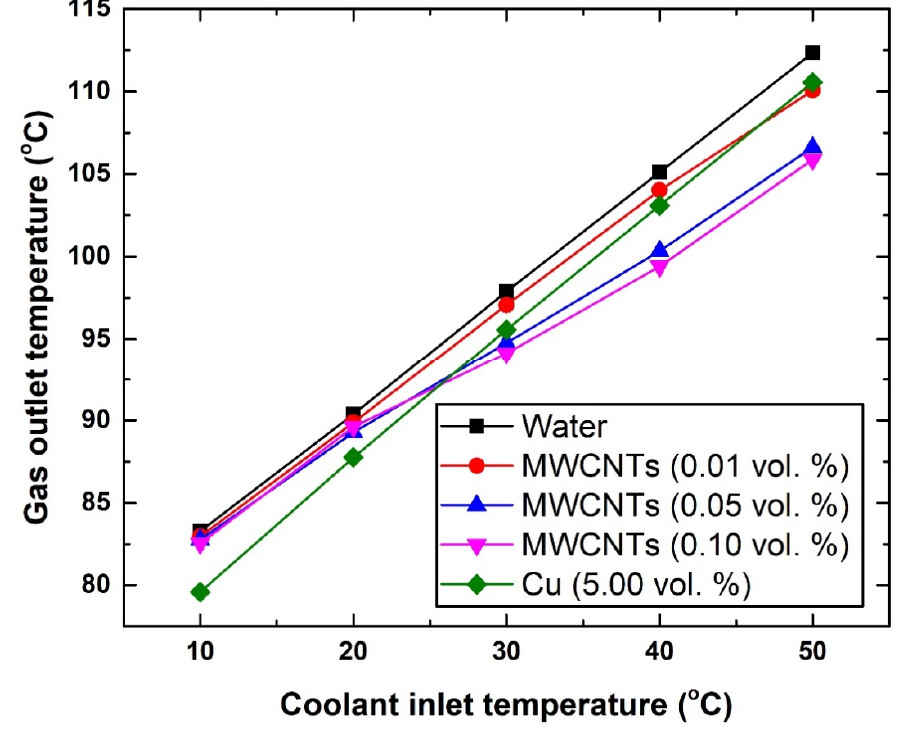
Figure 9. Changes in gas outlet temperature with respect to coolant inlet temperature and a fixed gas inlet temperature of 407 °C.